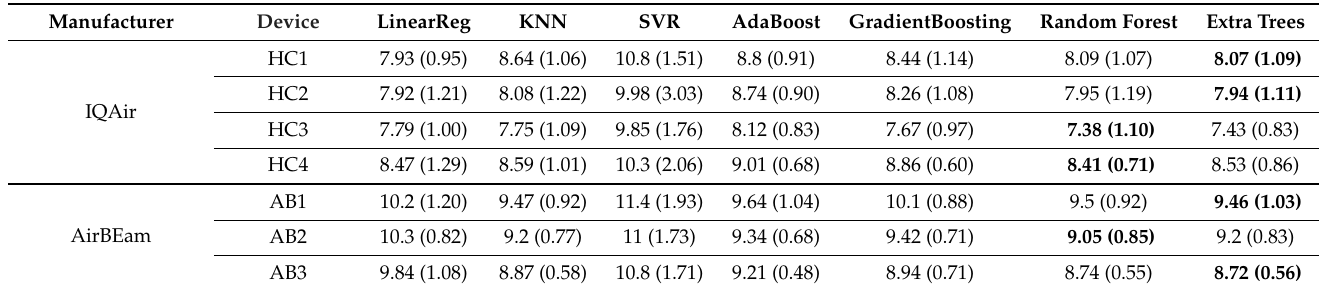
Table 2. Cross-validated RMSE values of different monosensor calibration methods for calibrating PM 10 sensor values (IQAir and AirBeam). The cross-validation has been performed on training data using 10 folds. Values in parenthesis are the standard deviation of the RMSE values obtained in the 10 folds. Bold numbers indicate the best values in each